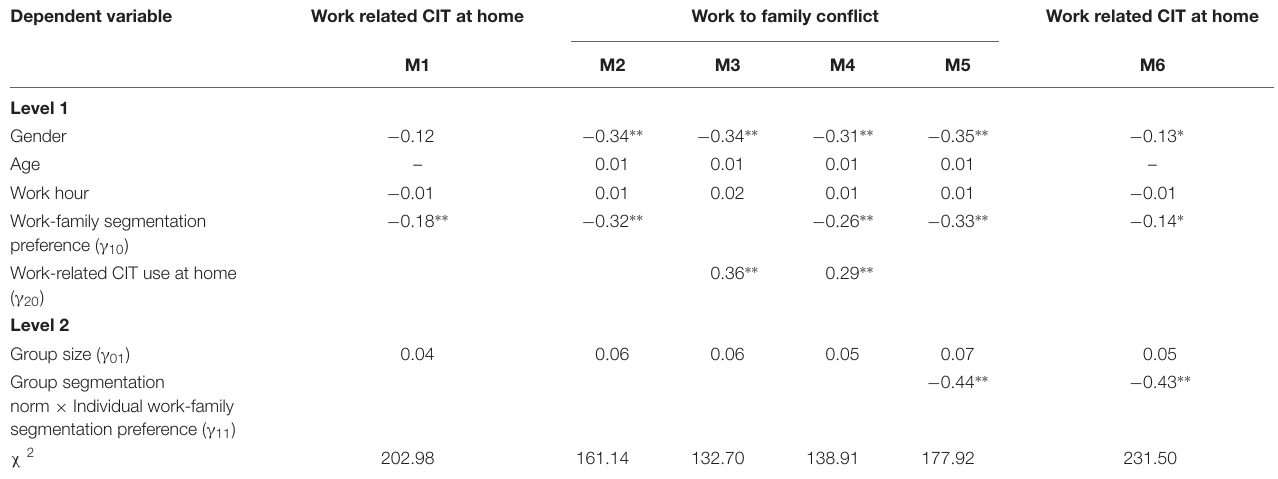
TABLE 2 | Summary of hierarchical multilevel analysis ( N =